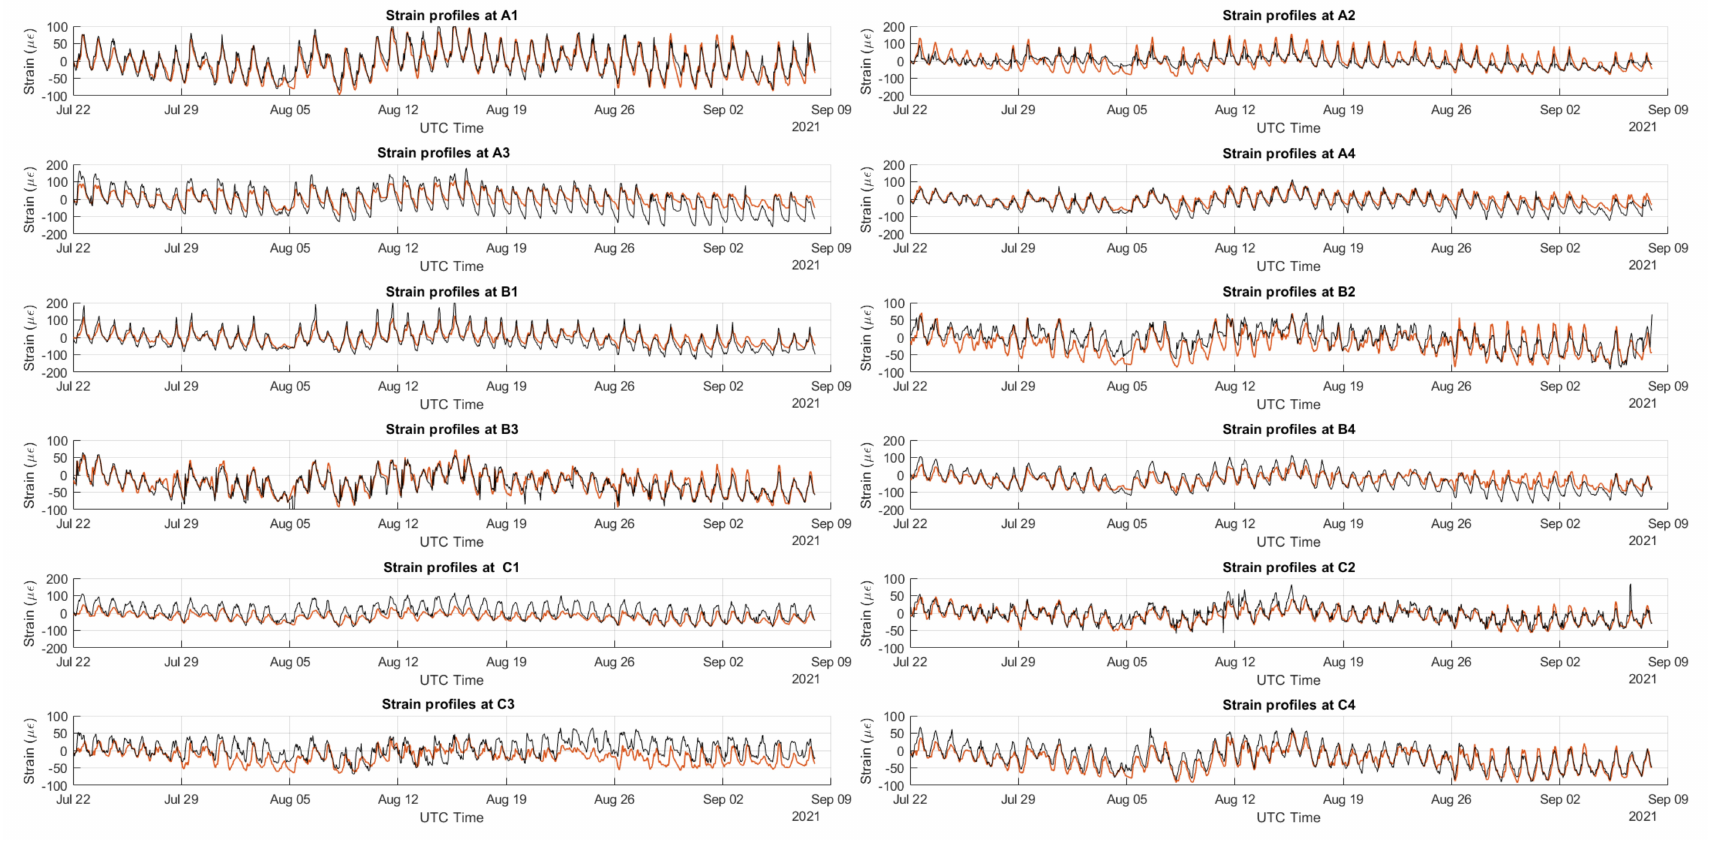
Figure 14. Comparison of the strain profiles at VW strain gauges